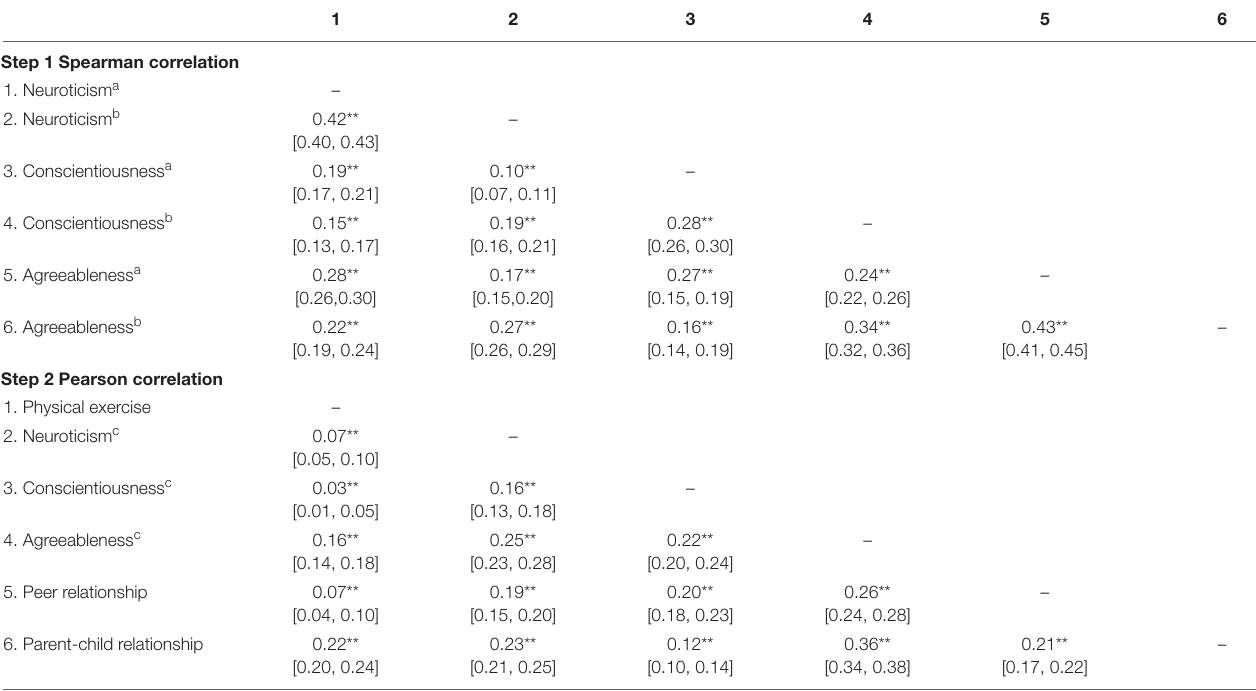
TABLE 2 | Correlations of variables ( N =